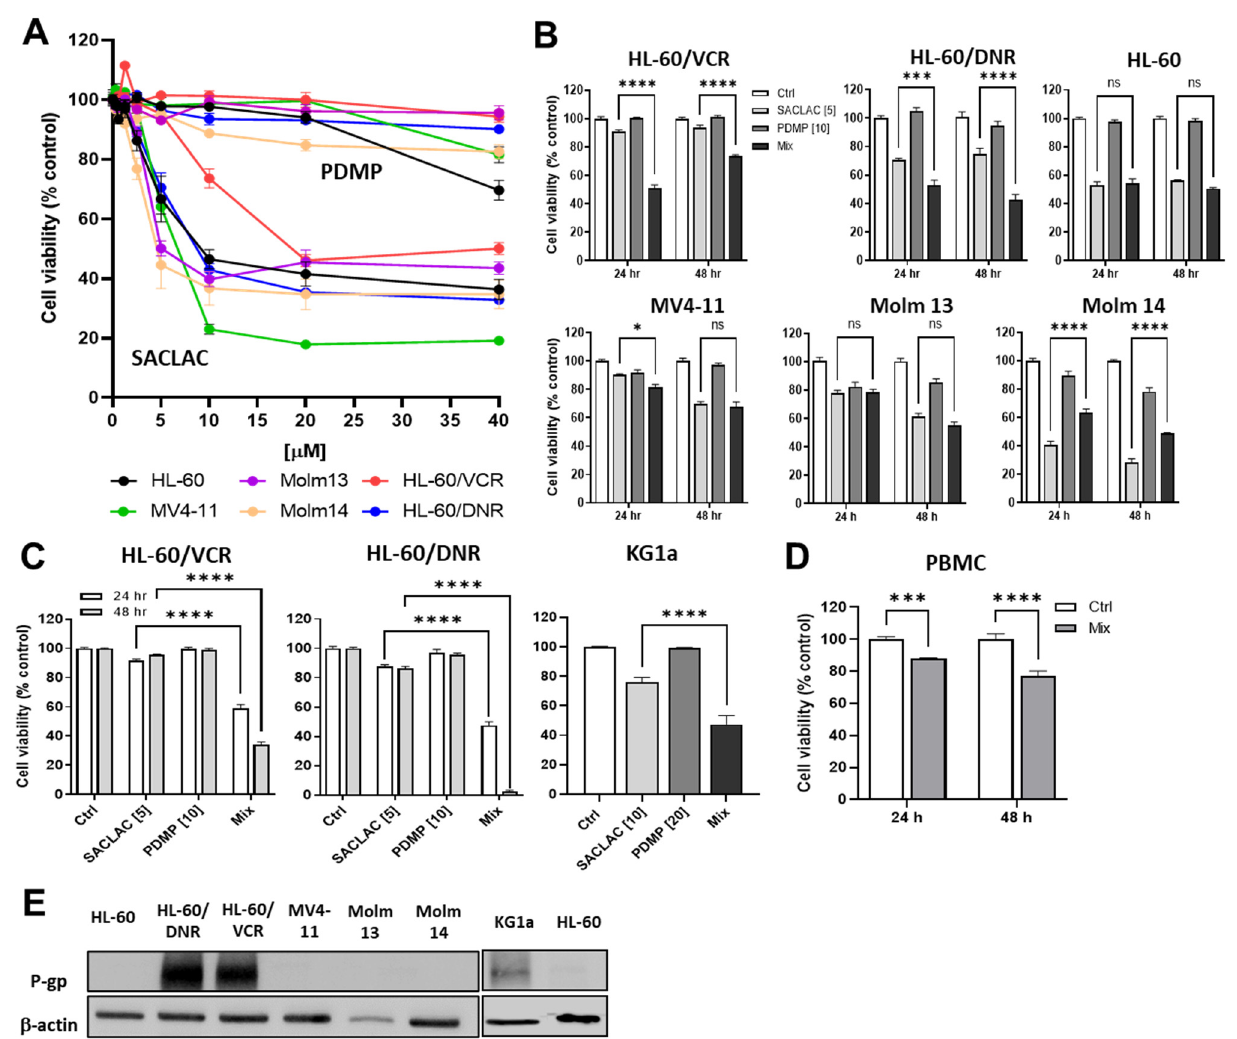
Figure 2. Impact of SACLAC and D- threo -PDMP exposure on viability in drug-resistant and wild-type human AML cell lines. ( A ) Impact of single agent exposure. Cells (50,000/well) were seeded into 96-well plates and exposed to either SACLAC or D- threo -PDMP for 24 h at the concentrations indicated. Cell viability was determined by PI assay. ( B ) Effect of single agent and mix regimens on AML cell viability. Exposure times and concentrations as indicated. Viability by PI assay. ( C ) Confirmation of combinatorial efficacy in HL-60/VCR, HL-60/DNR, and KG-1a cells by cell counting method. Cells (200,000/well) were seeded into 12-well plates in complete media and treated as indicated for the times shown (KG-1a, 24 hr treatment), after which viability was determined by trypan blue exclusion and cell counting. ( D ) Enzyme inhibitor sensitivity in PBMCs. PBMCs (200,000 cells/well) were seeded into 12-well plates in complete media and exposed to the agents indicated (5 µM SACLAC and 10 µM D- threo -PDMP) for the times shown, after which cell viability was determined by trypan blue exclusion and cell counting. ( E ) Western blot analysis of P-gp expression in AML cell lines. Numbers in brackets indicate µ M concentrations. Mix refers to SACLAC + PDMP at a 1:2 ratio. PDMP refers to D- threo -PDMP. PBMC, peripheral blood mononuclear cells. The uncropped bolts are shown in Supplementary Materials Figure S1. Data represent Mean ± SEM, ( A ) N = 6/group, ( B ) N = 6/group, ( C ) N = 3–6/group, ( D ) N = 3–6/group. Two-way ANOVA (Tukey’s multiple comparisons test) was used for statistical analysis (* p < 0.05, *** p < 0.001, **** p < 0.0001). ns, not